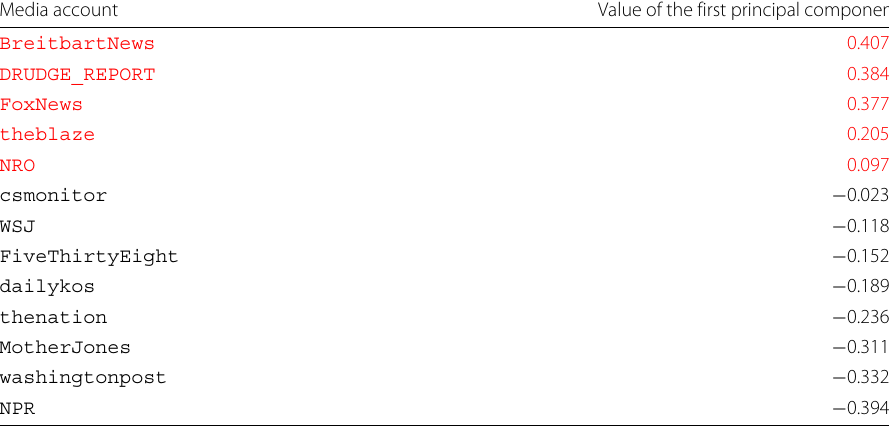
Table 1 First principal component of the media-followership matrix